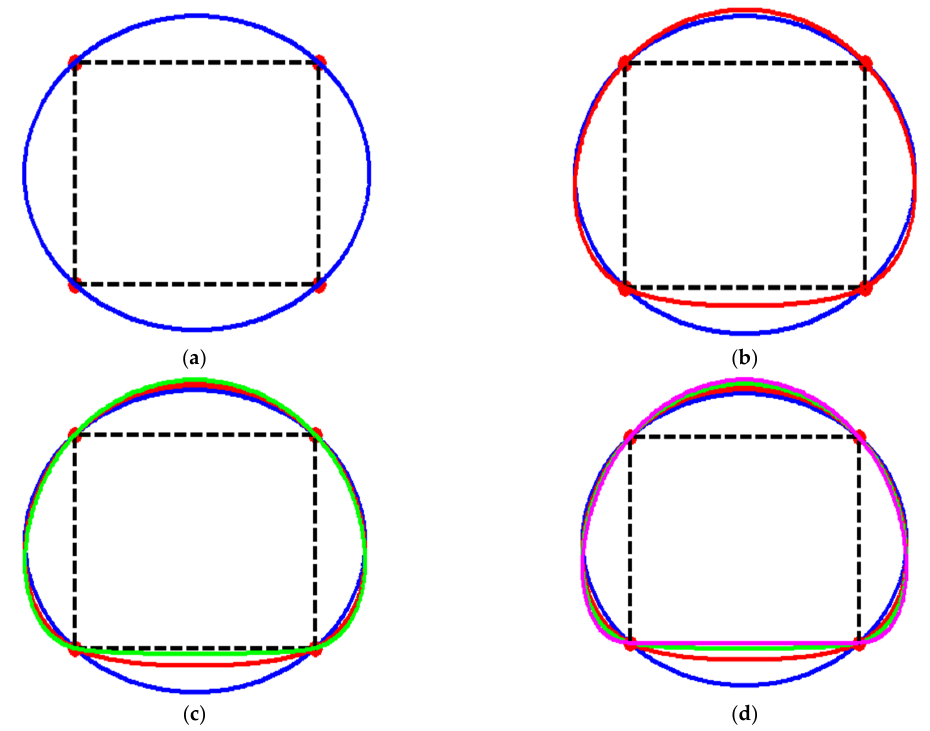
Figure 9. ( a – d ) are RQTS curve through global tension, by 𝜌 (cid:3038) (cid:3404) 𝜎 (cid:3038) (cid:3404) 2,3,5 , and 100, for any 𝑘 .